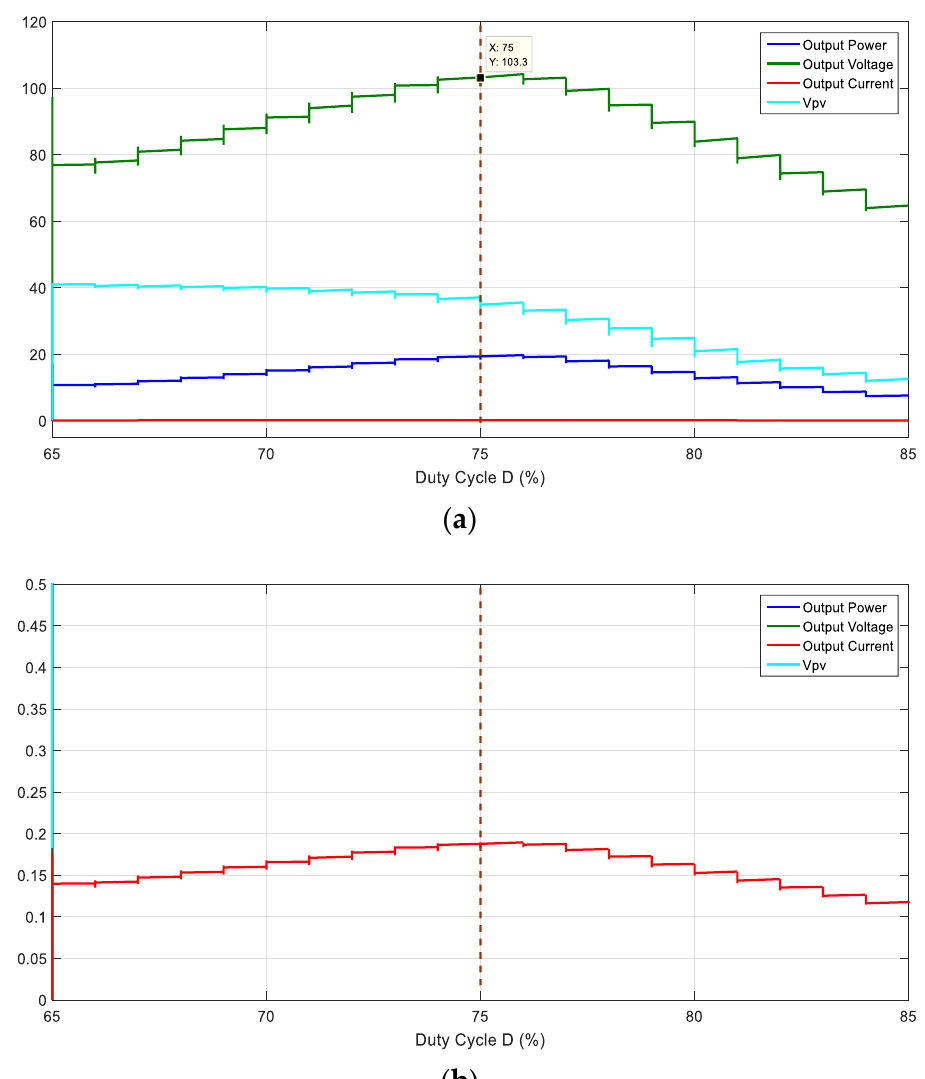
Figure 6. Buck-boost converter: graph of output voltage, output current, output power, and V PV with duty cycle.